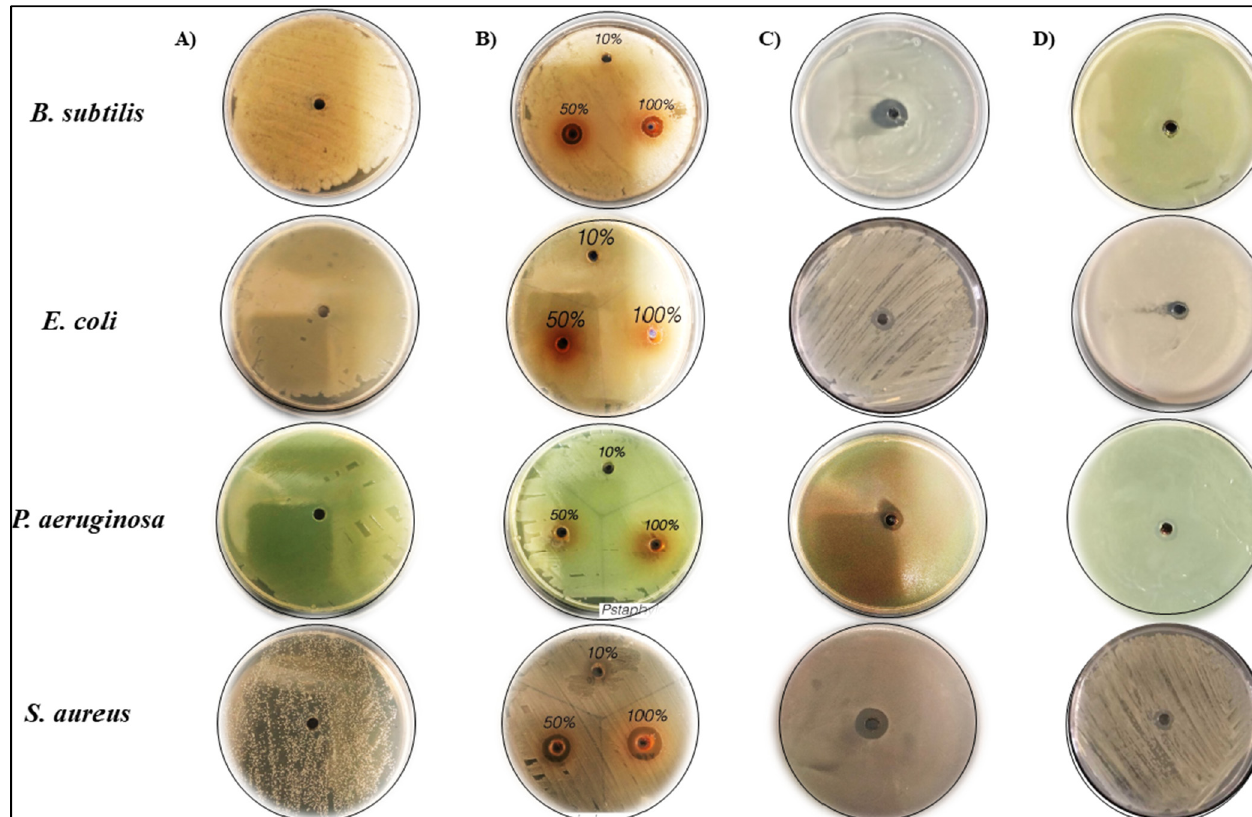
Figure 6 . The antibacterial activity of aqueous GSE and the biosynthesized GSE-AgNPs. The bacterial growth was detected by measuring the inhibition zone using the agar disk-diffusion method by the Mueller–Hinton Agar. The plates were treated with ( A ) Milli-Q water as control, ( B ) GSE extract (100%, 50%, & 10%), ( C ) 0.2 mL AgNO 3 , or ( D ) 0.2 mL GSE-AgNPs. The zone of inhibition was measured after seven days ImageJ at the scale of 2.61 pixels/mm.